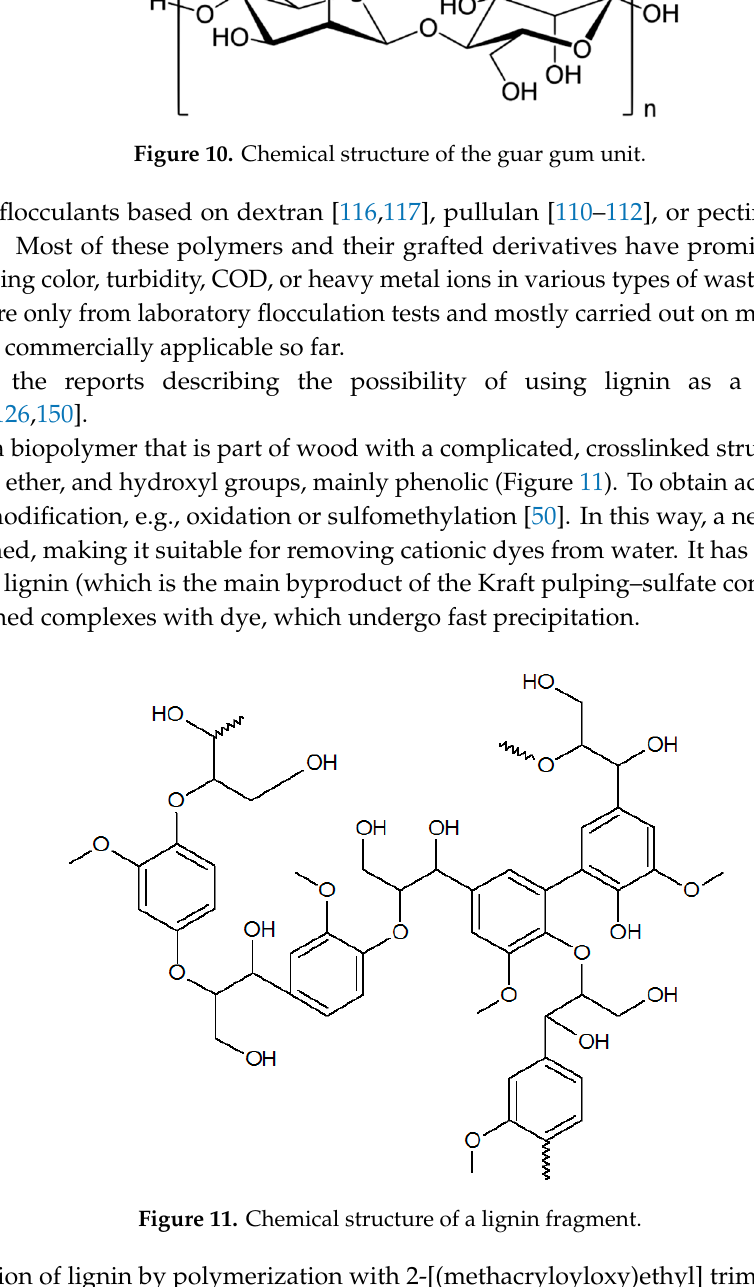
Figure 10. Chemical structure of the guar gum unit.